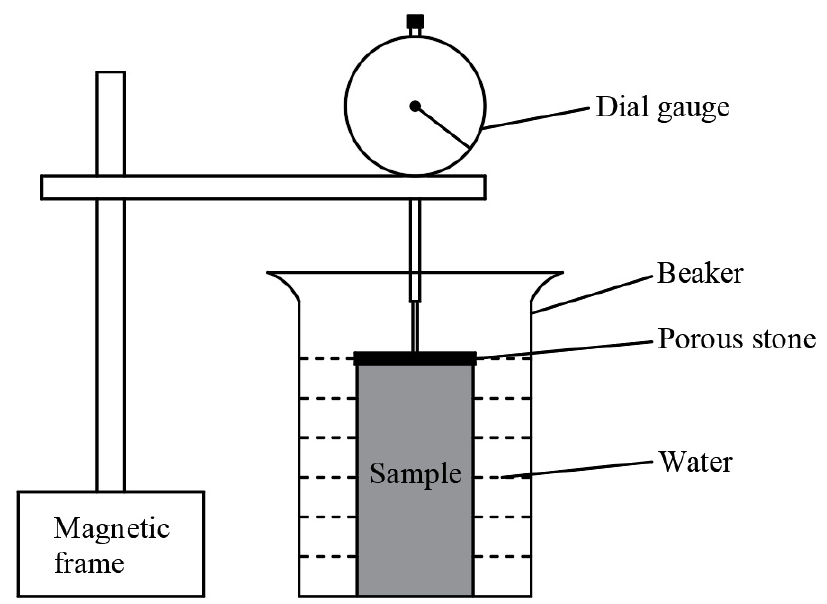
Figure 3. Schematic for the swelling test.